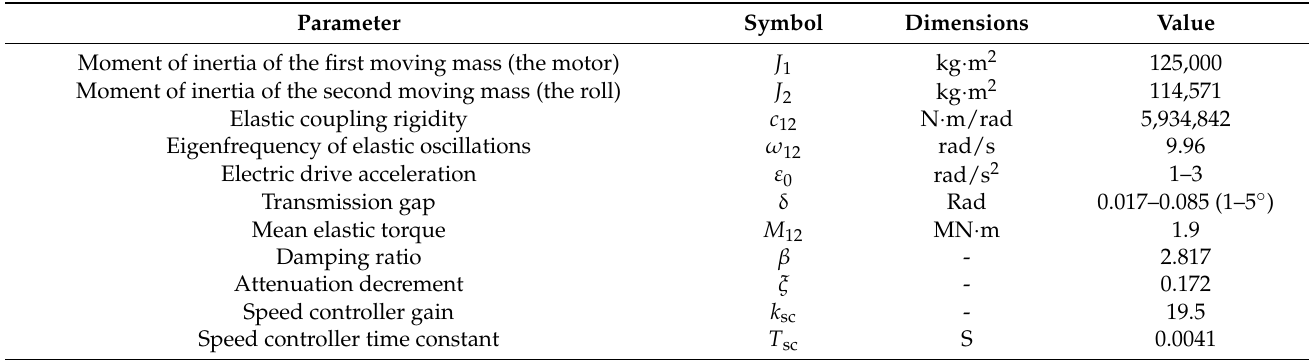
Table 1. Parameters of the dual-mass system model, Mill